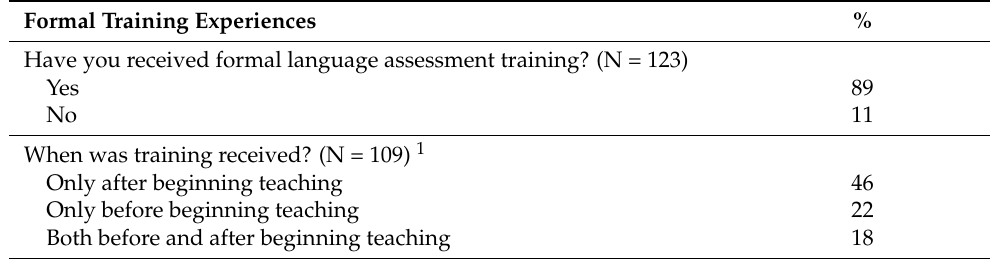
Table 2. Experience with formal and informal LAL learning.